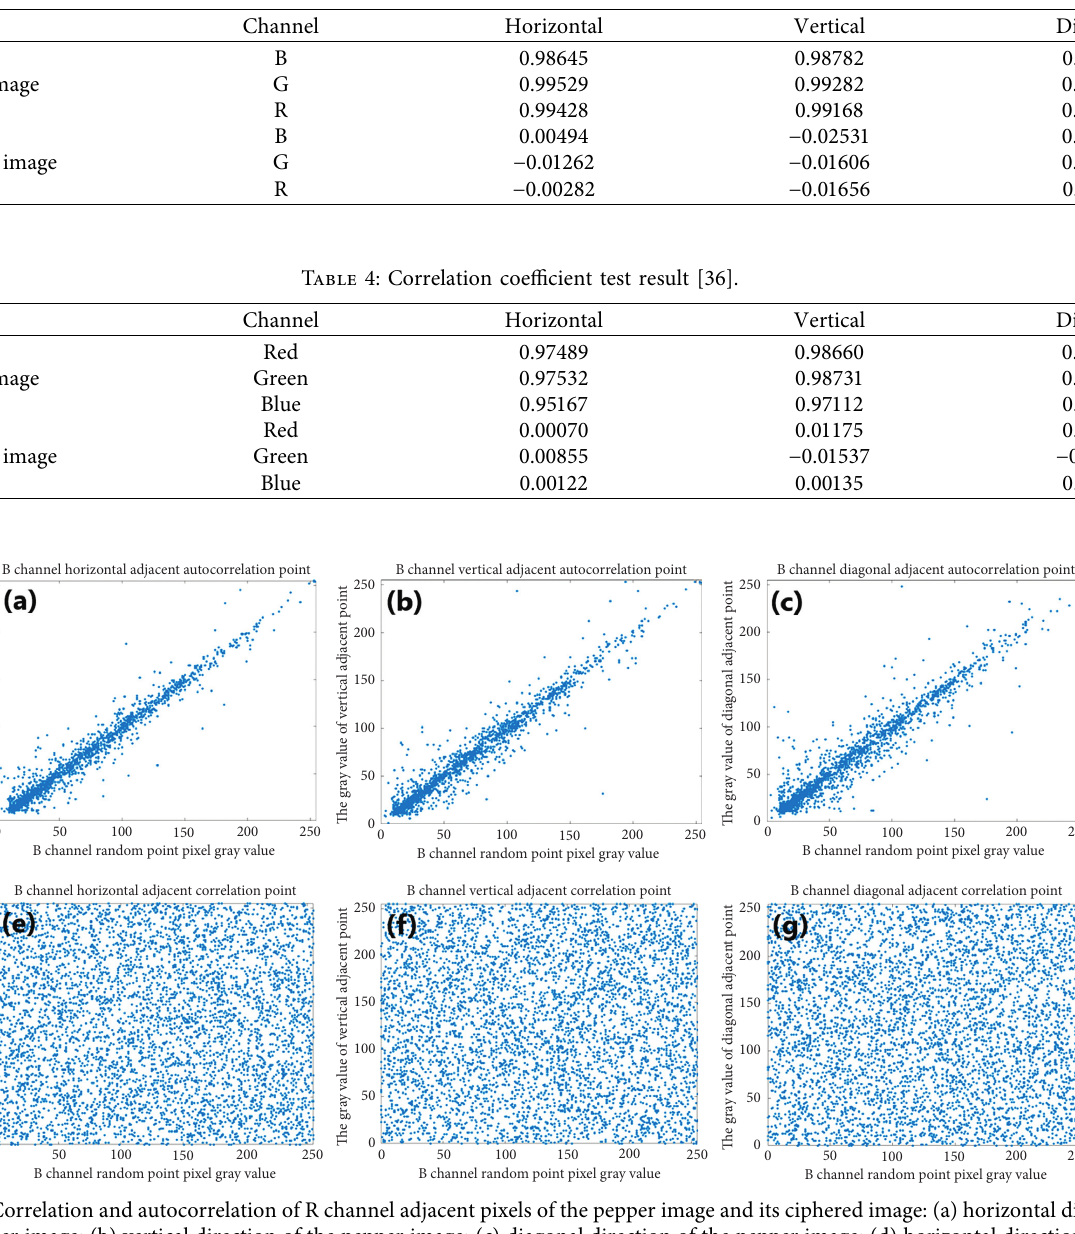
Figure 8: Histogram experiment images. (a–c) Histogram of the original image. (d–f) Histogram of the encrypted image. Table 3: A correlation coefficient of two adjacent pixels in the original and encrypted on the pepper image.